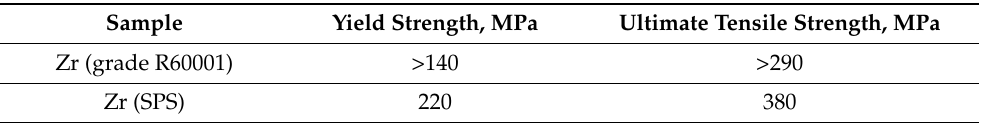
Table 4. Comparison of strength properties of zirconium R60001 grade and zirconium spark plasma sintered at 800 ◦ C meeting requirements of ASTM B-351 standard.